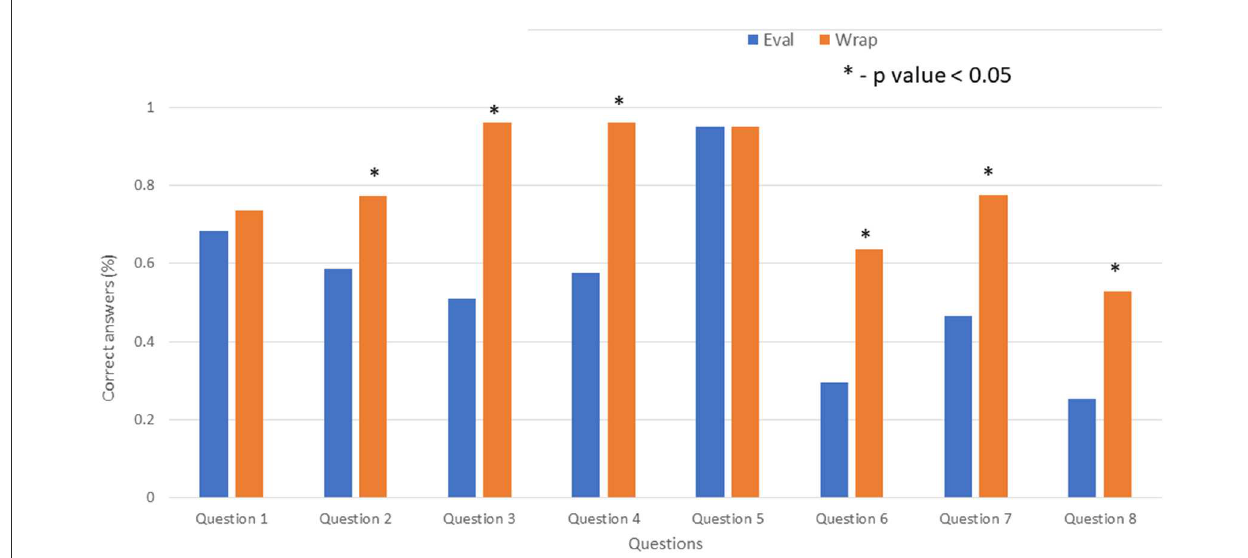
FIGURE2 Comparison of evaluation (Eval) and wrap visits. Asterisk indicates P < 0.05. Eval,